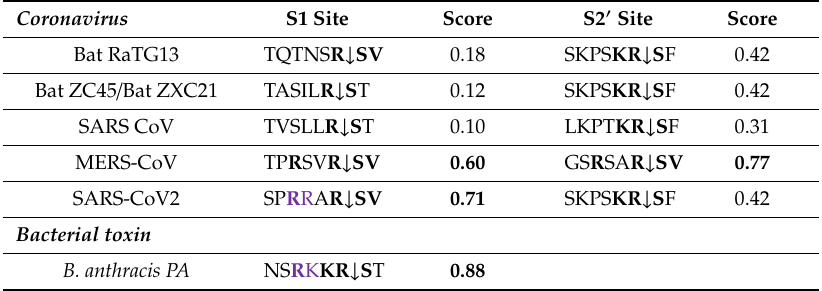
Table 1. Examined S1 and S2 ′ cleavage sites in selected coronavirus strains. In bold are residues that are preferred by furin-like proteases. In S1 and S2 ′ sequences, purple residues indicate preferred TMPRSS2 cleavage preferences: R ↓ K > R ↓ R >> R ↓ S. A score value indicative of furin cleavage preference for each motif is also reported.